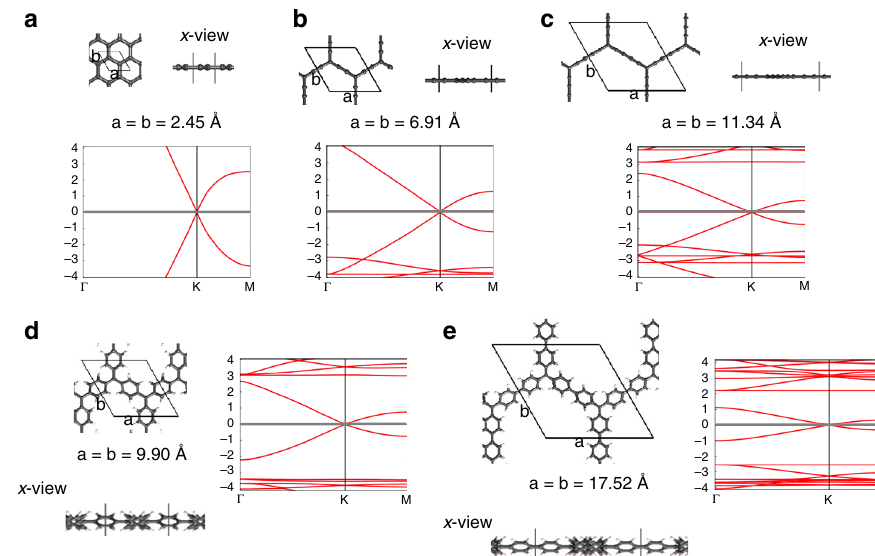
Fig. 2 Semimetallic state. Fully optimised structures of: a graphene, b GY, c GDY as obtained from spin-unrestricted calculations using the PBE0 hybrid functional. The results for GP ( d ) and GDP ( e ) were obtained from single point PBE0 calculations using fully symmetrised structures. The unit cell used in each case is highlighted from both z and x views, indicating the optimised cell parameters. The corresponding electronic band structures are also provided, setting E F to zero energy in each case. Band structure energies are in eV. The broken symmetry structures for GP and GDP and their associated band structures are shown in Supplementary Fig.